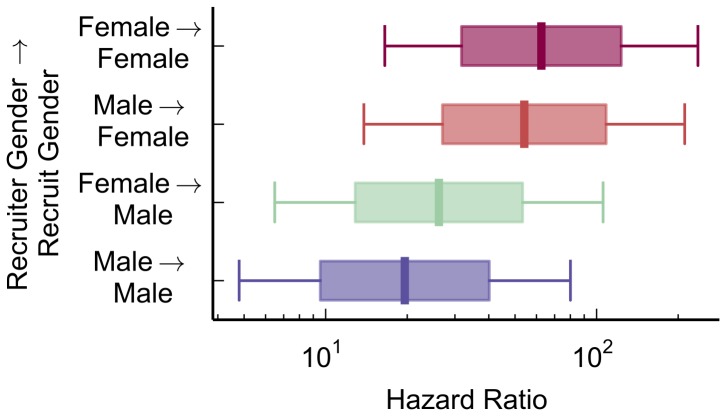
Females mobilized other females faster than males mobilized other males.No homophily effect was observed, as the recruiter and the recruit being of the same gender did not yield higher mobilization speeds. (p>.05). In all figures hazard ratios are the increase (>1) or decrease (<1) in likelihood of registering for the contest on a given day, reflecting an increase or decrease in mobilization speed. Boxes represent standard errors, and whiskers represent 95% confidence intervals. Redder boxes indicate faster mobilization (higher hazard ratios), while bluer boxes indicate slower mobilization (lower hazard ratios). Unless otherwise noted, the reference rate (hazard ratio  = 1) is for participants who did not give data on that variable, or recruiter-recruit pairs in which at least one of the participants did not give data.